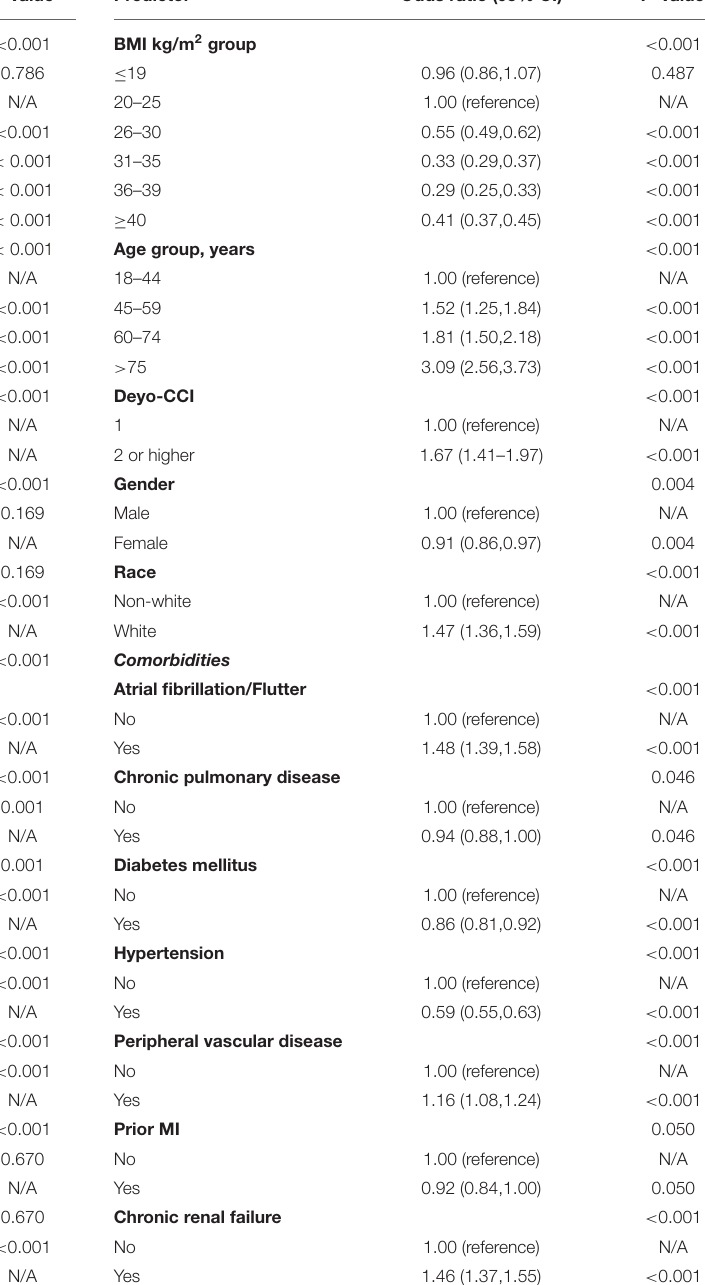
TABLE 3 | Multivariable analysis for predictors of in-hospital mortality, 2015–2016.